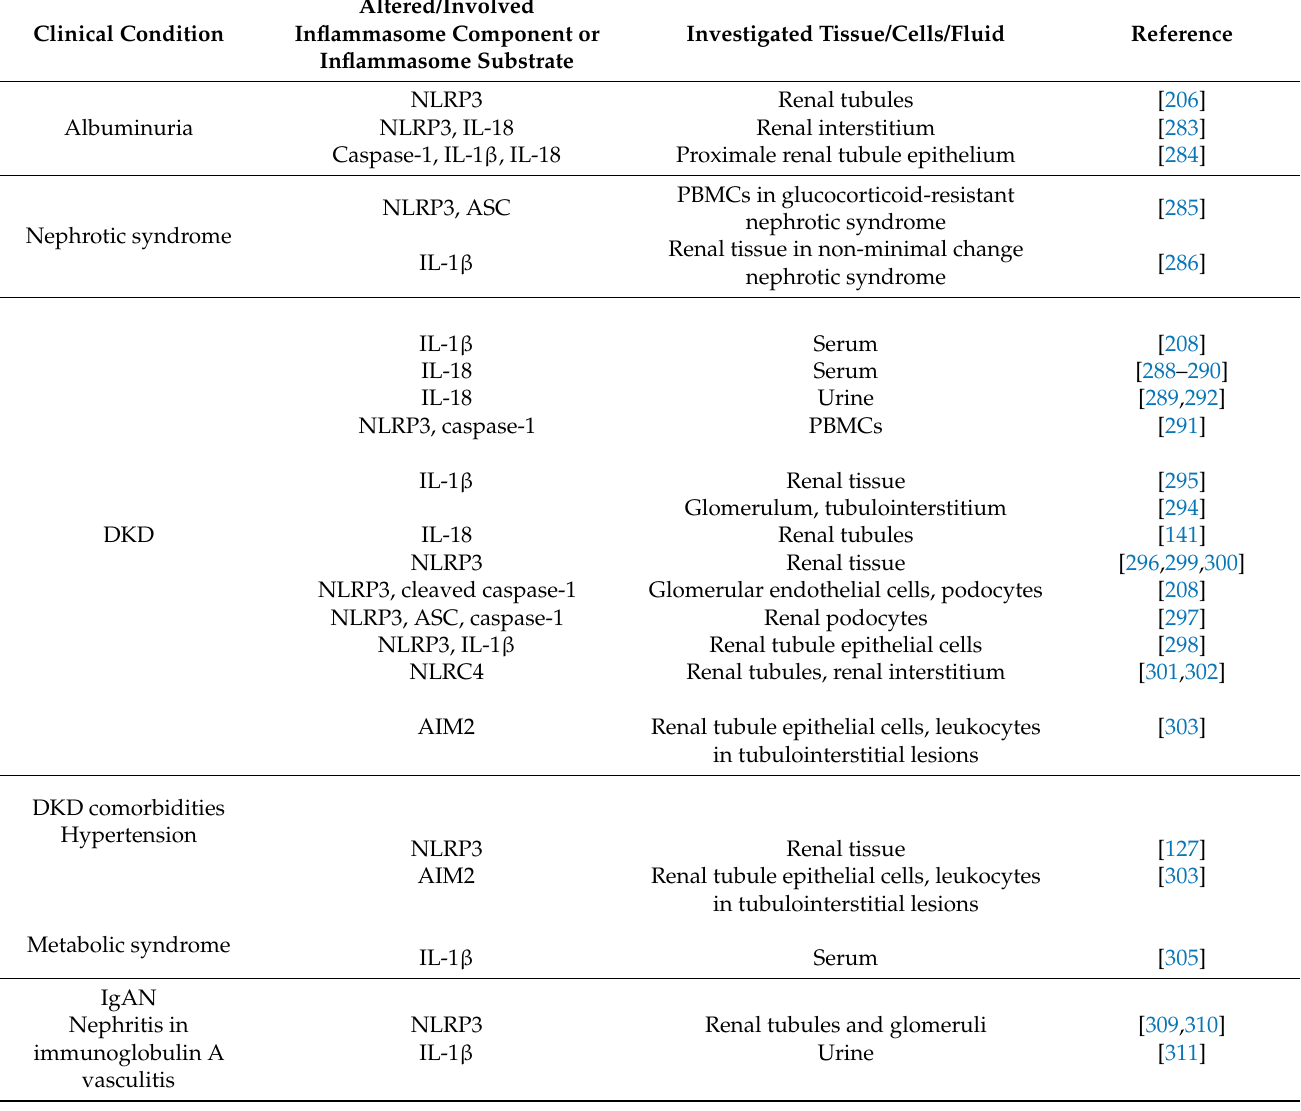
Table 6. Inflammasome component involvement in